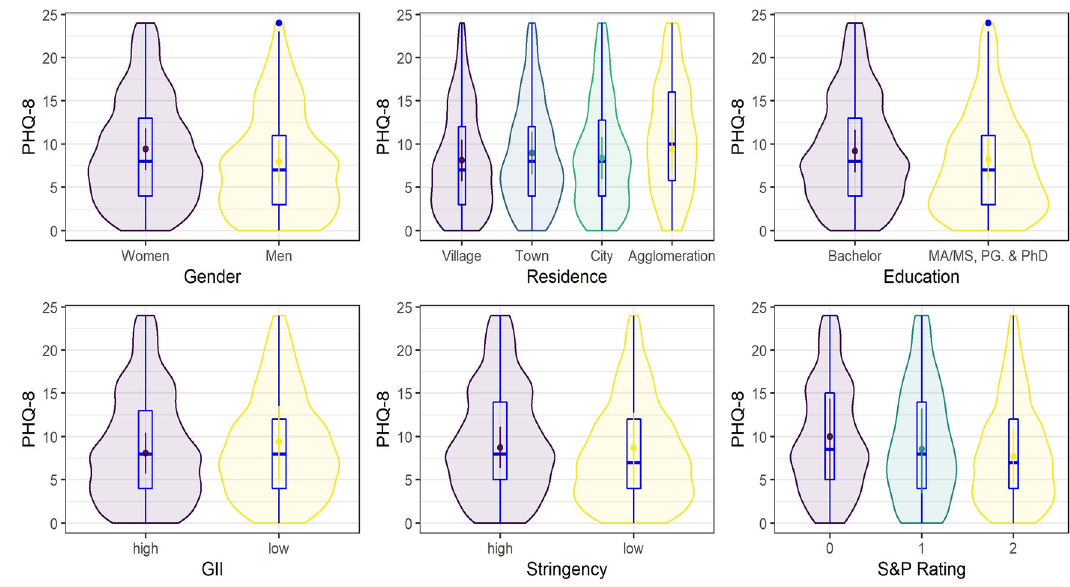
Figure 5. Posterior means of predicted marginal means (points) with 95% credible intervals (vertical lines) from the Bayesian skew-normal multilevel model for depression (PHQ-8) scores. Boxplots and violin plots show the distribution of the